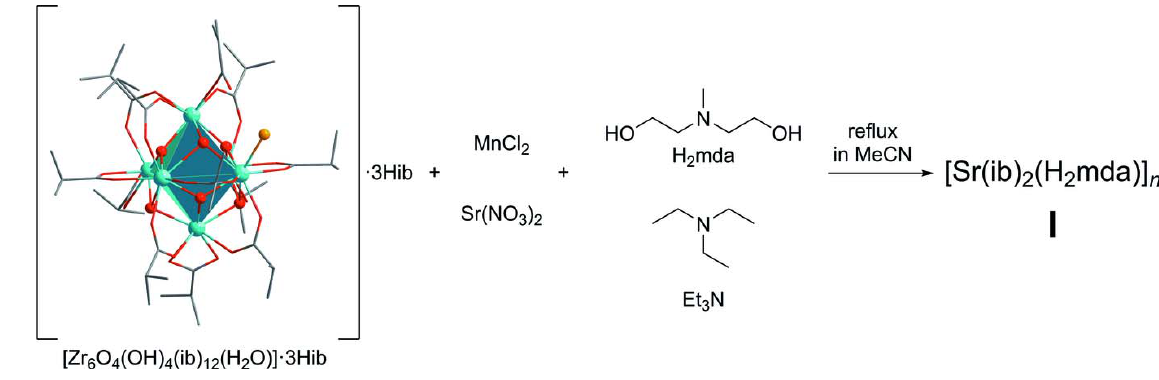
Figure 5 Synthesis of compound I .